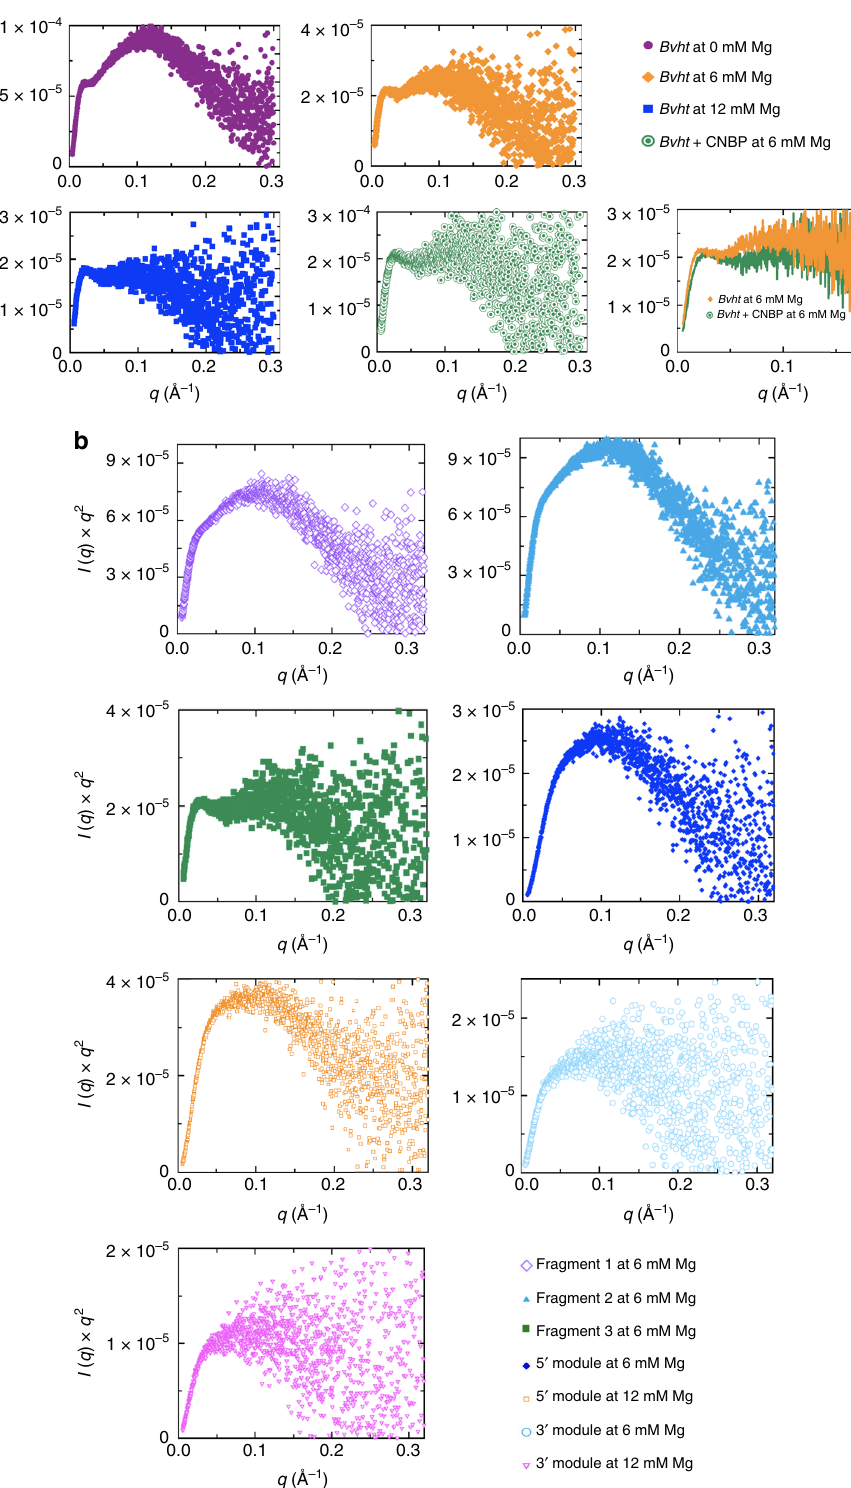
Fig. 2 Kratky plots of Bvht . a Data of the full-length Bvht at various Mg 2 + concentrations and of the Bvht -CNBP complex show that overall, all RNA molecules are folded. Upon binding with CNBP, full-length Bvht undergoes a conformation change (bottom right). b Data of Bvht